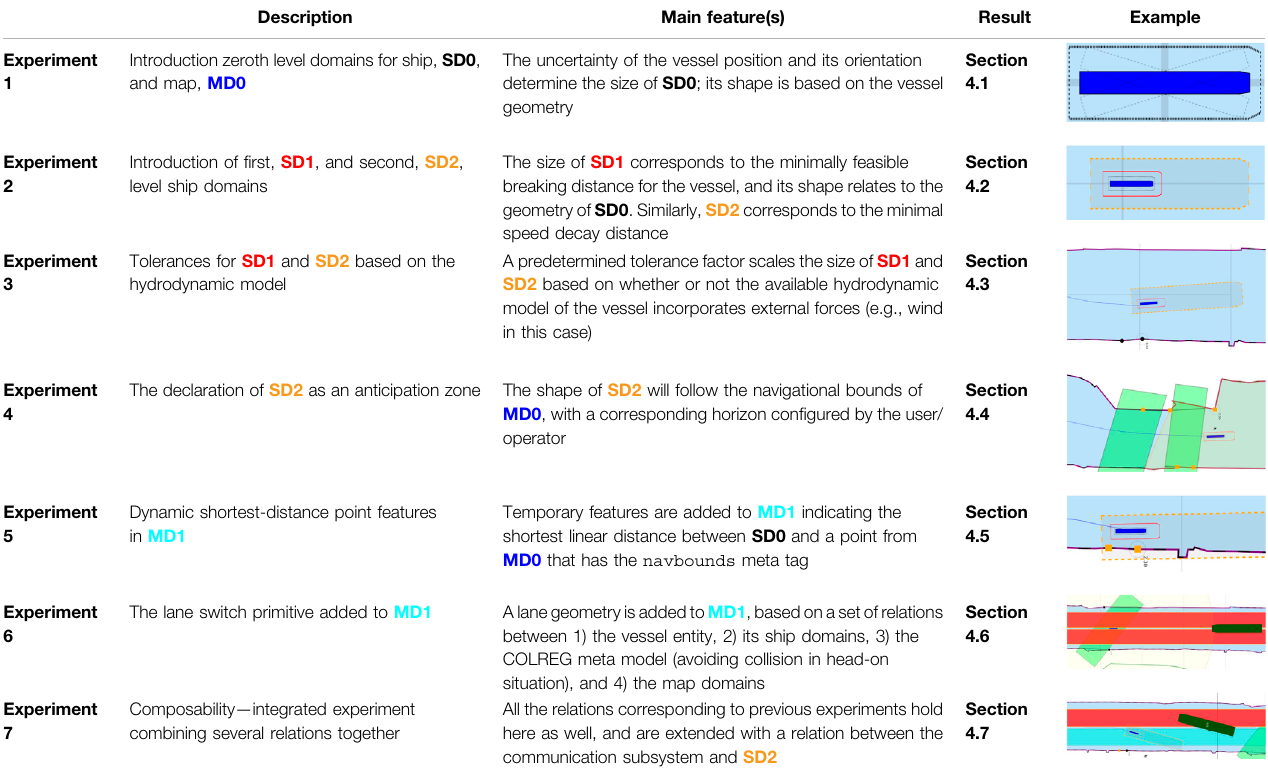
TABLE 1 | Overview experiments: short description, main features, and reference to corresponding